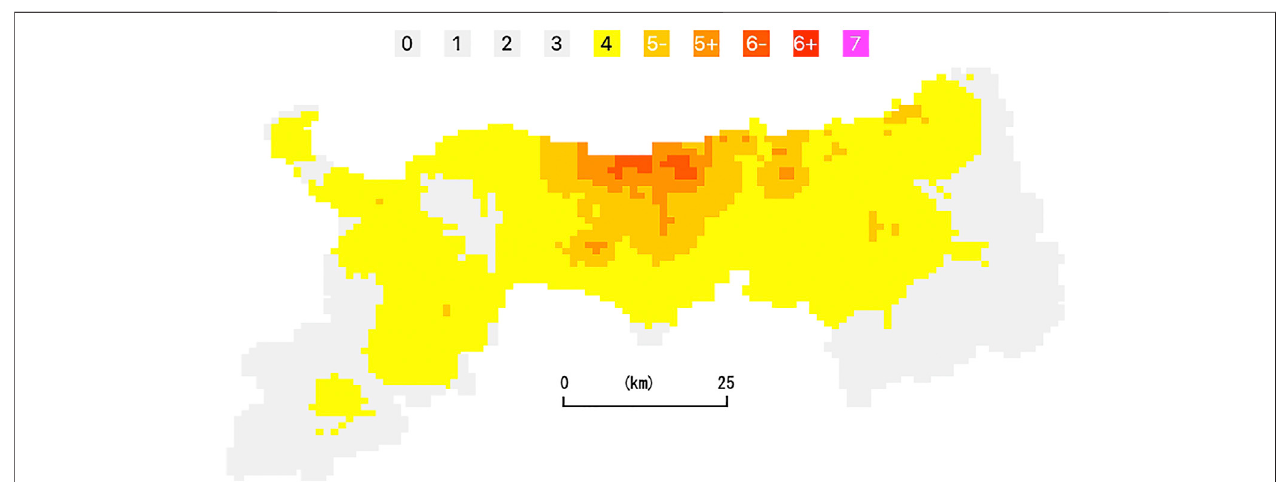
FIGURE 9 | Same as Figure 5 but after introducing estimation from P-wave amplitude.